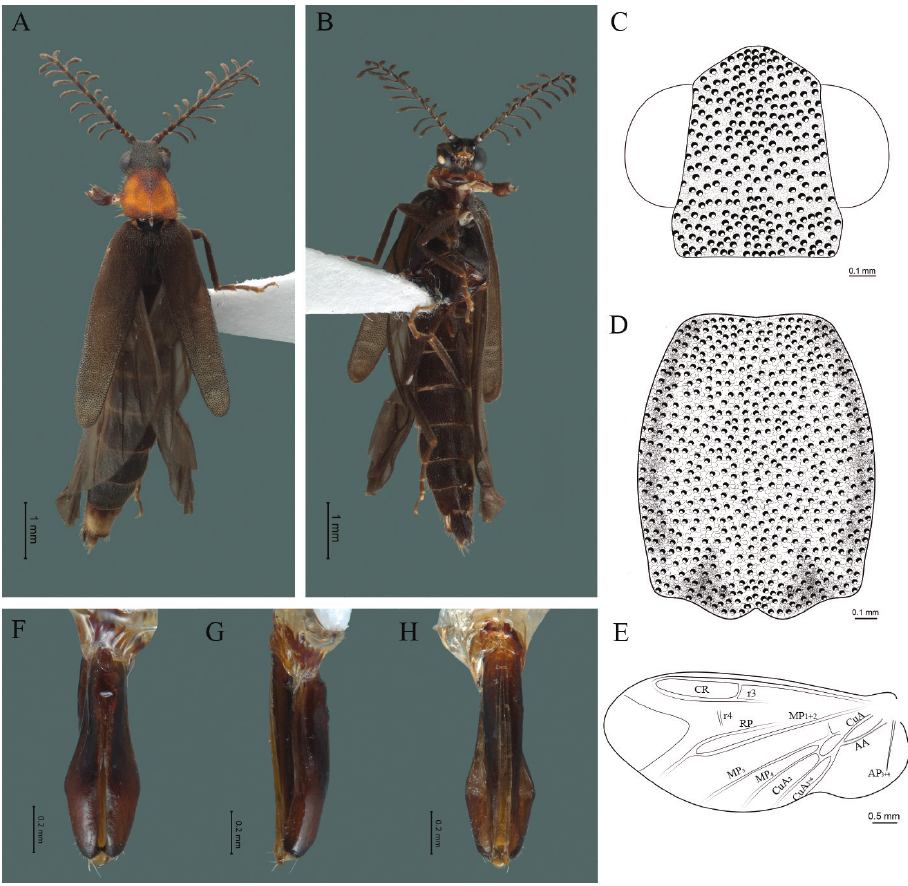
Figure 24. Cenophengus pedregalensis Zaragoza-Caballero, 1975, male. Habitus: A dorsal B ventral C head dorsal D pronotum dorsal E hind wing. Wing venation: CR = Radial Cell; r3 = radial 3 vein; r4 = radial 4 vein; RP = Posterior Radial vein; MP1+2 = Posterior Median vein; CuA = Cubital vein; AA and AP = Anterior and Posterior Anal veins. Aedeagus: F dorsal view G lateral view H ventral Redescription. Male. Body length 7.2–10.5 mm, maximum body width 1.01– 1.10 mm (pronotum). Body dark brown, antennae black to brown, pronotum yellow- orange (Fig. 24A, B). Head . Wider (0.86–0.96 mm) (0.91 ± 0.061 mm, n = 11) than long (0.60–0.70 mm) (0.63 ± 0.041 mm, n = 11) (Fig. 24C), at eye level, less